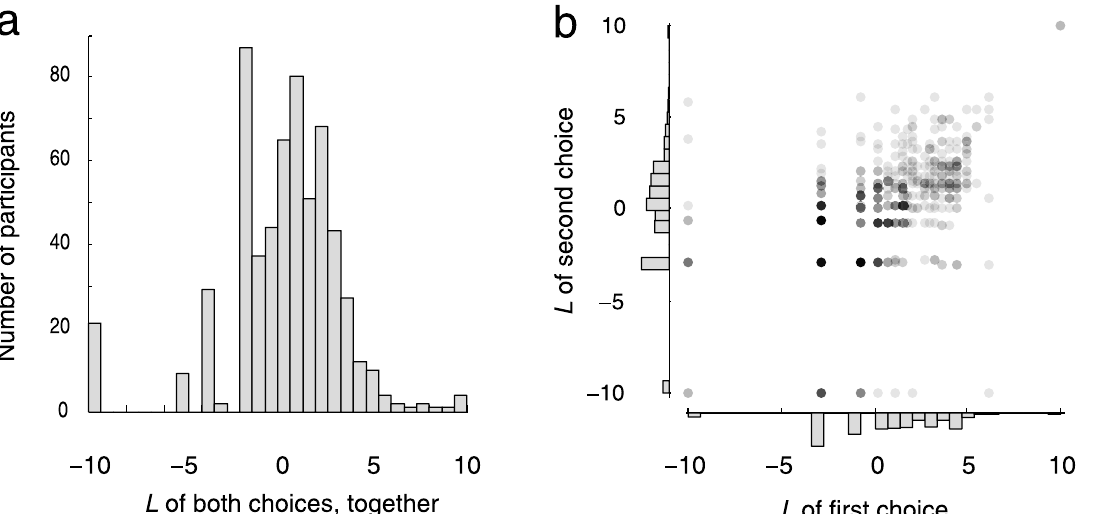
Fig 3. Individual differences in sensitivity to popularity when selecting whom to befriend. (A) Distribution of the best-fit value of L across participants. (B) Correlation between the best-fit values of L for a participant's first and second selections, fit separately.